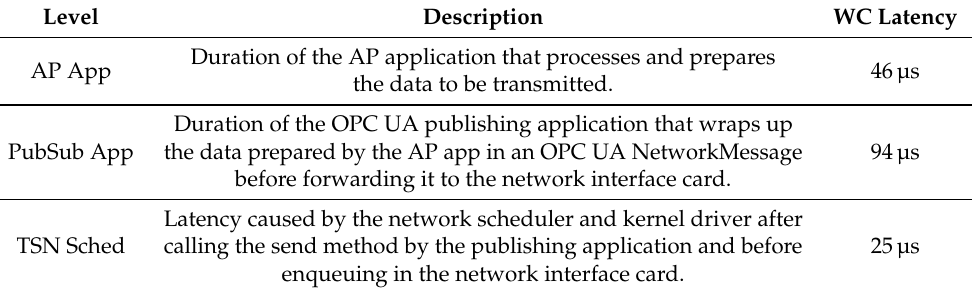
Table 1. Worst-case (WC) measured latencies on different levels of the publishing